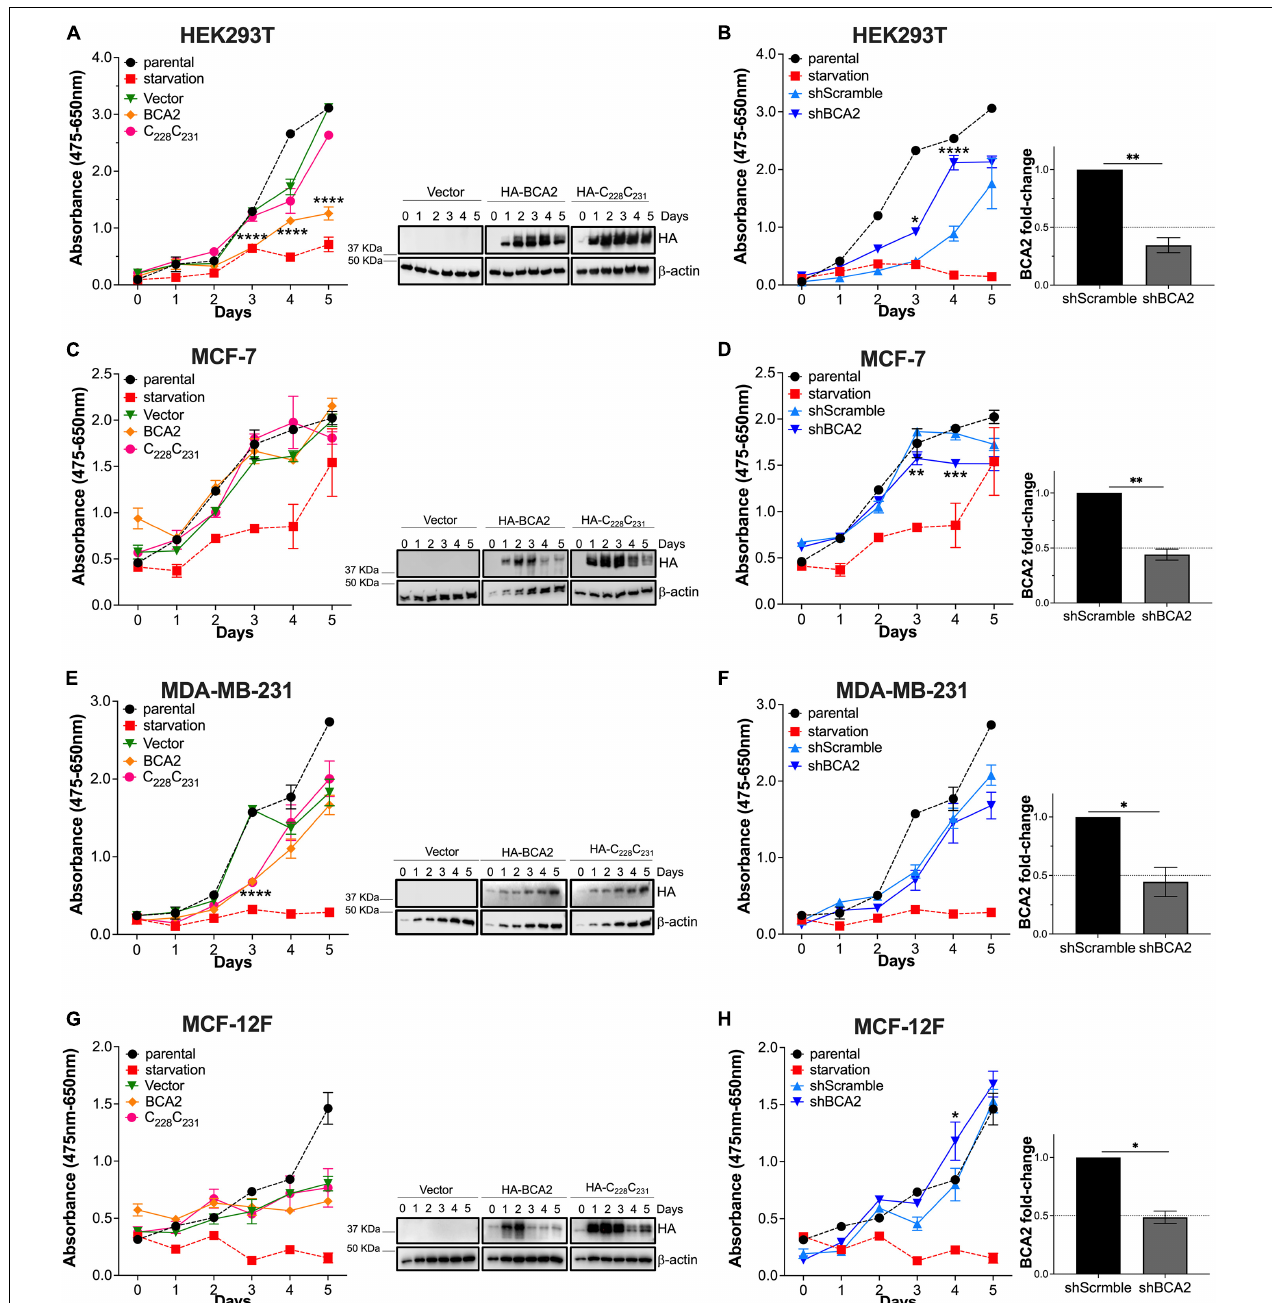
FIGURE 1 | Effects of BCA2 on metabolic activity. (A,C,E,G) Cells, including HEK293T cells (A) , MCF-7 (C) , MDA-MB-231 (E) , and MCF-12F (G) were transfected with constructs encoding for HA-BCA2, a BCA2 catalytic-defective mutant (HA-C 228 C 231 ) or an empty vector control. Cellular metabolic activity was measured over time by XTT assays. As controls, parental cells and cells under nutrient deprivation were included. Representative western blots for the expression of HA-BCA2 and HA-C 228 C 231 are shown next to the graphs. (B,D,F,H) Similar experiments were performed in cells stably transduced with a scrambled shRNA or depleted of BCA2. BCA2 depletion was verified on the first and last day of analysis by RT-qPCR (right panels show BCA2 levels on day 5 of the assay). Dotted lines represent threshold for biological significance. Data correspond to the mean and SEM of 3 independent experiments. * p < 0.05, ** p < 0.01, *** p < 0.001, **** p <